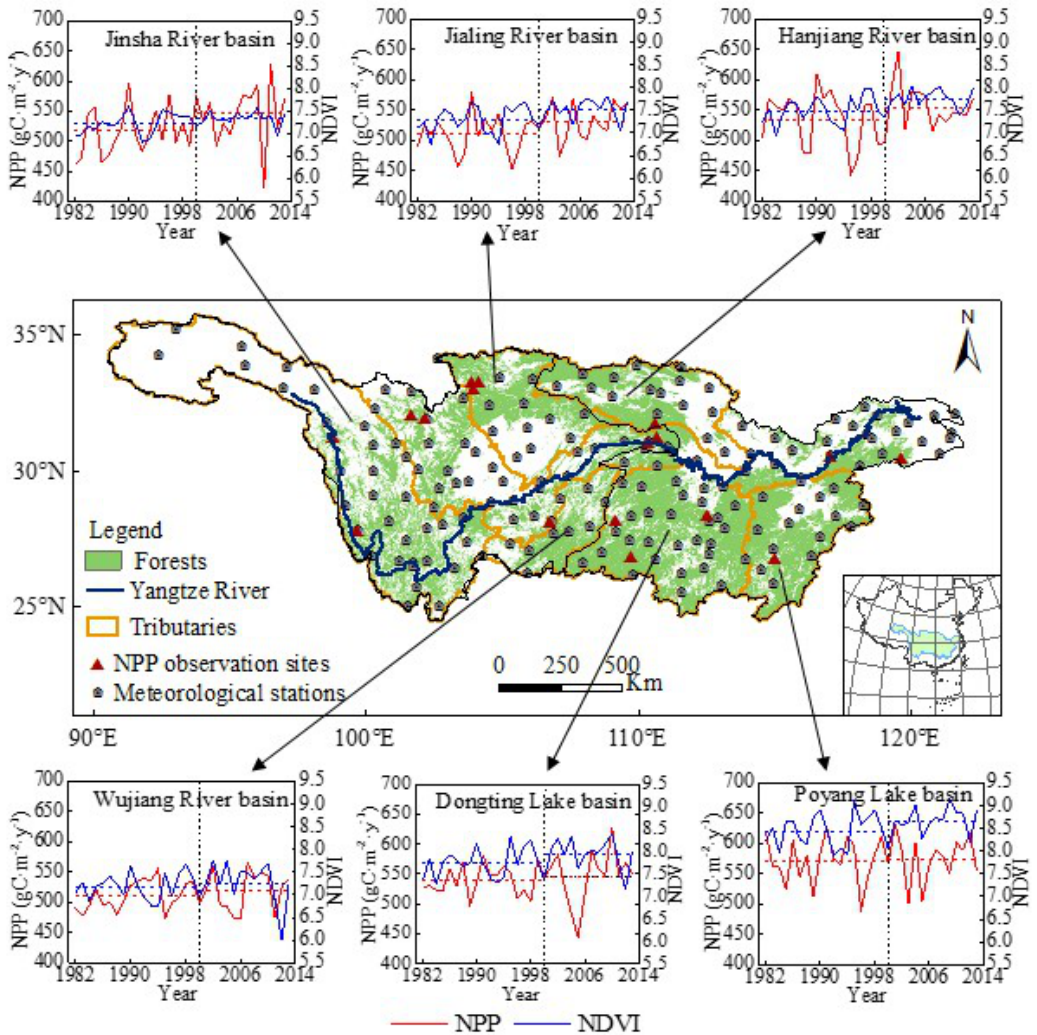
Figure 1. Location of the observed meteorological station and NPP (Net Primary Productivity) sites over the Yangtze River basin and the forest distribution map in the year 2000.